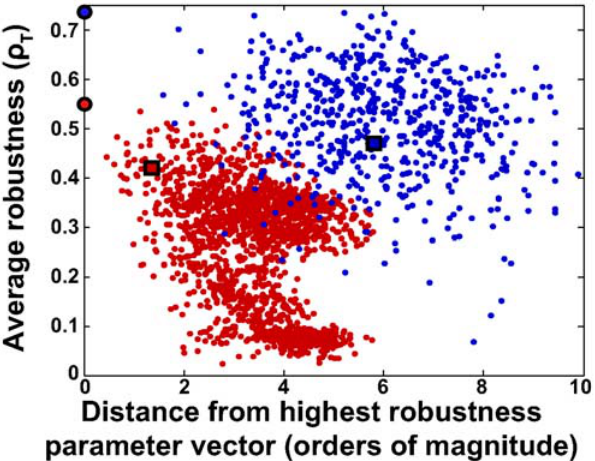
Figure 5. Distribution of the average local robustness r T for the two models. For each viable parameter vector k , the figure shows its distance (horizontal axis) from the viable parameter vector with the highest average local robustness r T plotted against the r T of k (vertical axis); autocatalytic model (red) and two-sites model (blue). Large circles correspond to the two parameter vectors with the highest r T for each model, and squares correspond to published parameter vectors [31,32]. The greater the distance of k to the most robust parameter vector, the lower its r T . This negative association is stronger for the autocatalytic